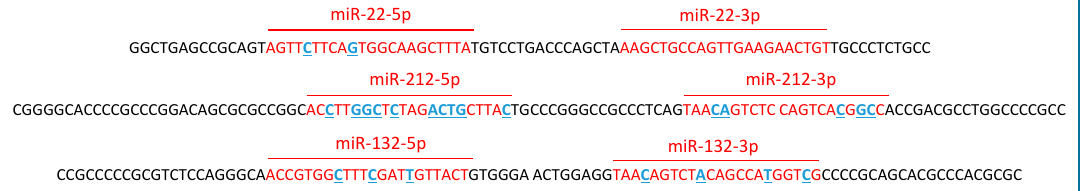
Figure 3. Alterations in miR-22 expression level, genomic location, and sequence. ( a ) Differential expression profile of miR-22-3p (miR-22), miR-132-3p (miR-132), and miR-212-3p (miR-212), in breast cancer, according to dbDEMC 3.0 database. ( b ) The number of breast cancer studies where miR-22 expression has been found up-regulated (black) or down-regulated (grey), according to Fig. 3. Alterations in miR-22 epression level, genomic location and sequence. dbDEMC. ( c ) Breast cancer samples available at TCGA (OncoLnc analysis) were divided at the median expression levels of hsa-miR-22-3p. The survival curve was then calculated for high (above the median, red) and low (below the median, blue) expression. ( d ) The ratio of the number of amplifications (+) and deletions ( − ) reported on cBioportal database for the indicated microRNAs in all tumors and in breast cancer (BRCA), hepatocellular carcinoma (HCC) and prostate cancer (PC). ( e ) The number of amplifications (+) and deletions ( − ) of miR-22, miR-132, and miR-212 in BRCA patients reported in the cBioportal database. ( f ) The number of amplifications (left) and deletions (right) reported on the cBioportal database for CRK , PITPNA-AS1, and HIC1 in 205 studies. See the text for details about the cases highlighted by the black and red arrows. ( g ) Base pair variations in miRNA sequences reported in GenomAD browser. Red: mature miRNA sequence; blue: base pair variation; black: pre-miRNA